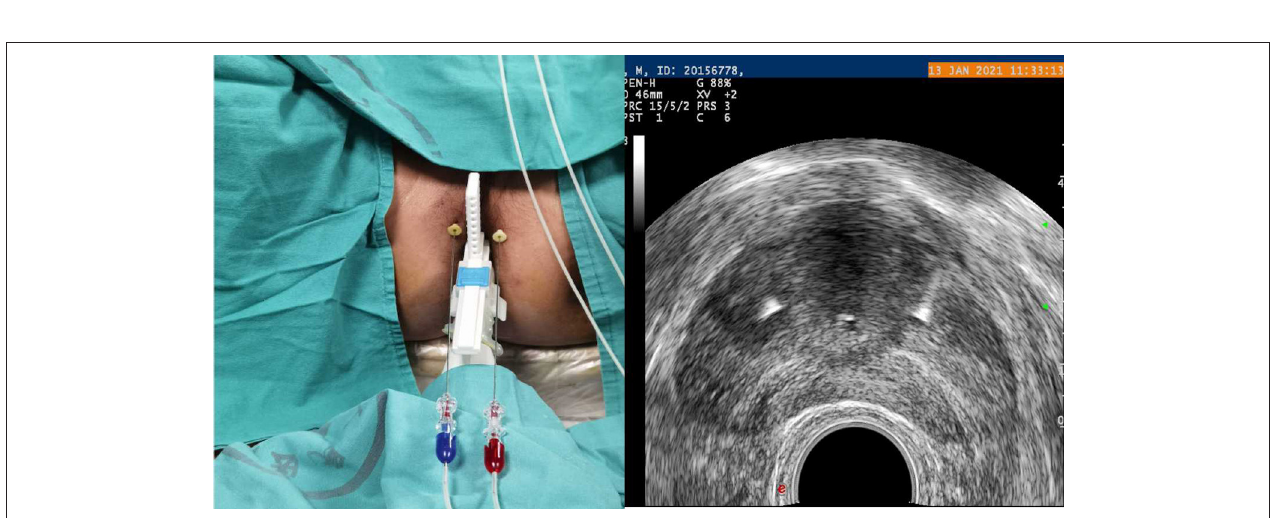
FIGURE 3 | Planning of the procedure. Two fibres for a prostate volume smaller than 40ml (one for each side).